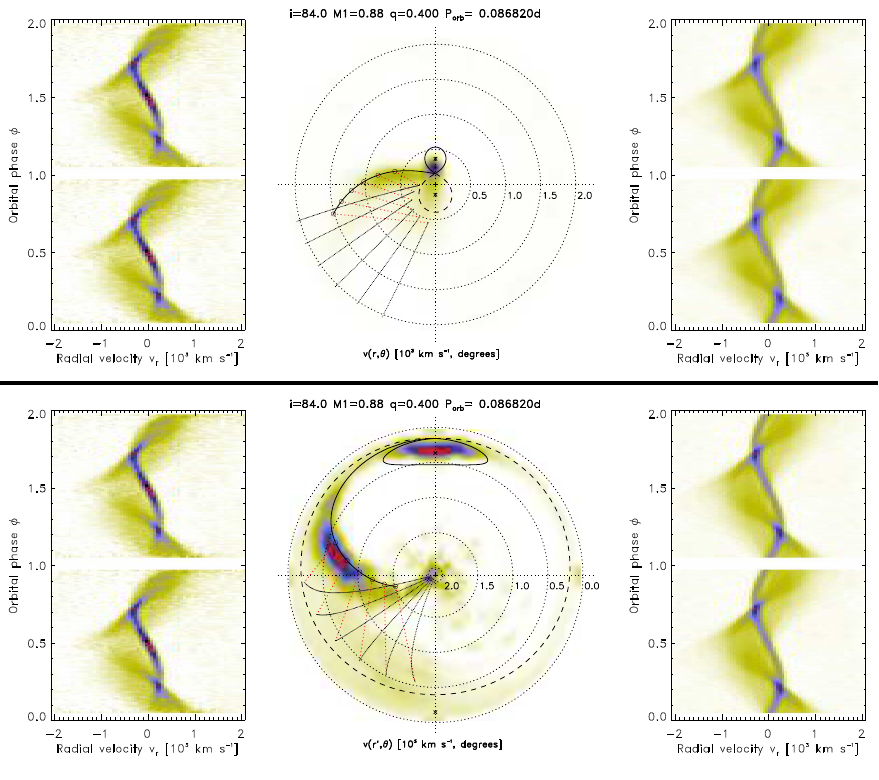
Figure 4: Doppler tomography of HU Aqr. Normal (top) and inside-out (bottom) tomograms are shown for comparison. The input and reconstructed trailed spectra are shown in the left and right panels,